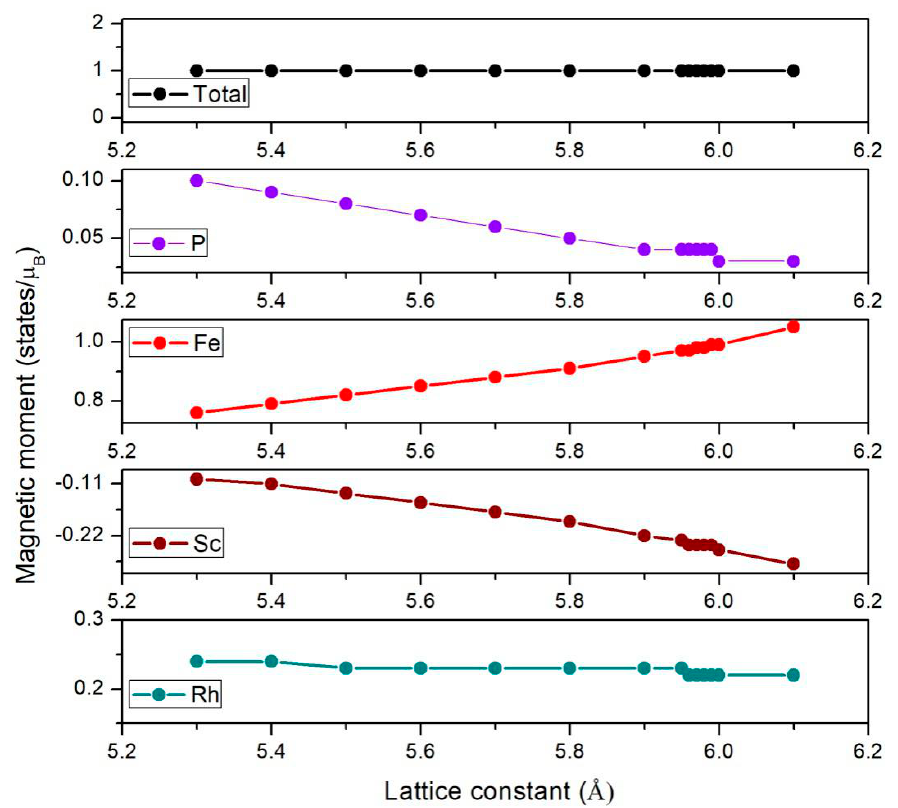
Figure 7. Partial and total magnetic moments as a function of the lattice constant of the ScFeRhP EQH compound.